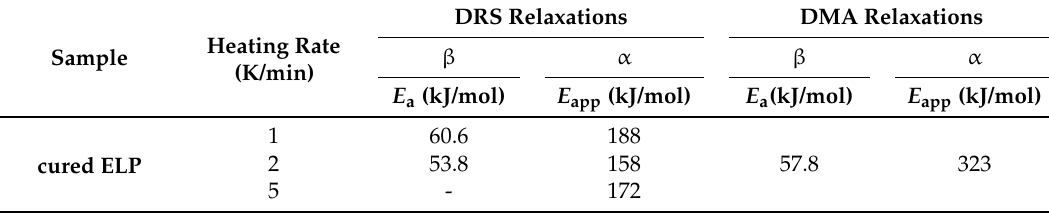
Table 4. Activation energies for the cured ELP system, obtained by DRS and DMA.